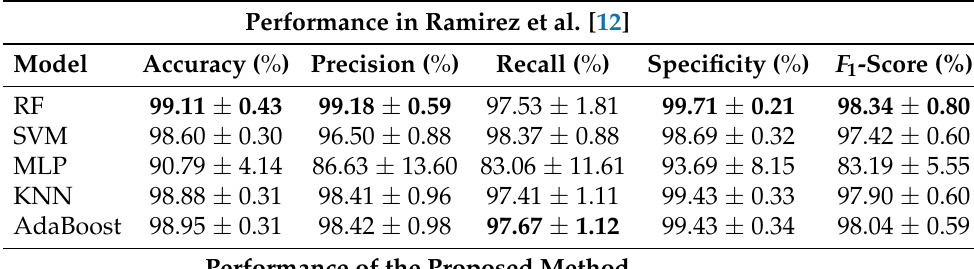
Table 7. Performance (mean ± standard deviation) obtained for each model of the proposed fall detection system using UR-Fall. Best results are shown in bold.